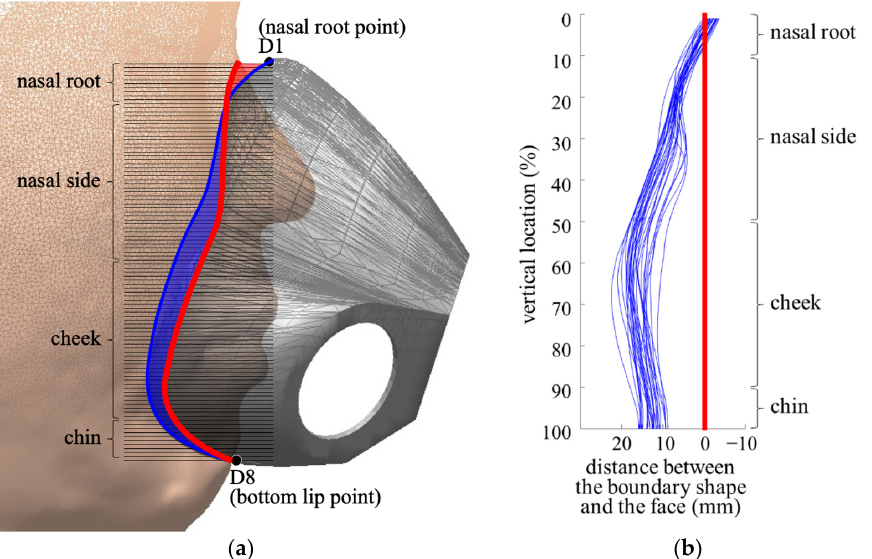
Figure 3. Virtual fit analysis by calculating horizontal distances between the mask boundary and 3D face surfaces (illus- trated). ( a ) Horizontal distances between the mask boundary and the face surface along the vertical axis with an interval of 1% of the mask length (blue line: mask boundary; red line: face surface, red shaded area: mask boundary region of negative horizontal distances causing oxygen leakage; blue shaded area: mask boundary region of positive horizontal distances causing contact pressure to the face); ( b ) plots of the horizontal distances between the mask boundary and face surfaces of a small narrow size group ( n = 29).